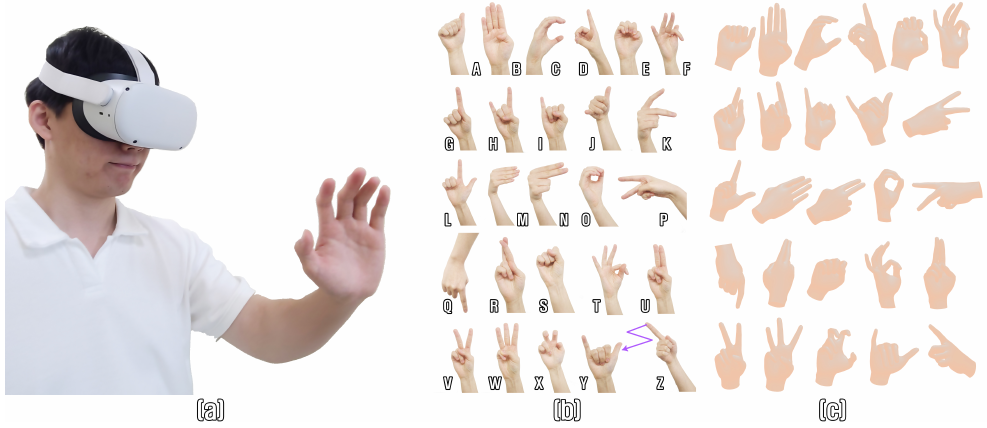
Figure 2. Gesture configuration of the VR user interface: ( a ) gesture is input using an HMD with a built-in hand tracking function, ( b ) real hand, and ( c ) virtual